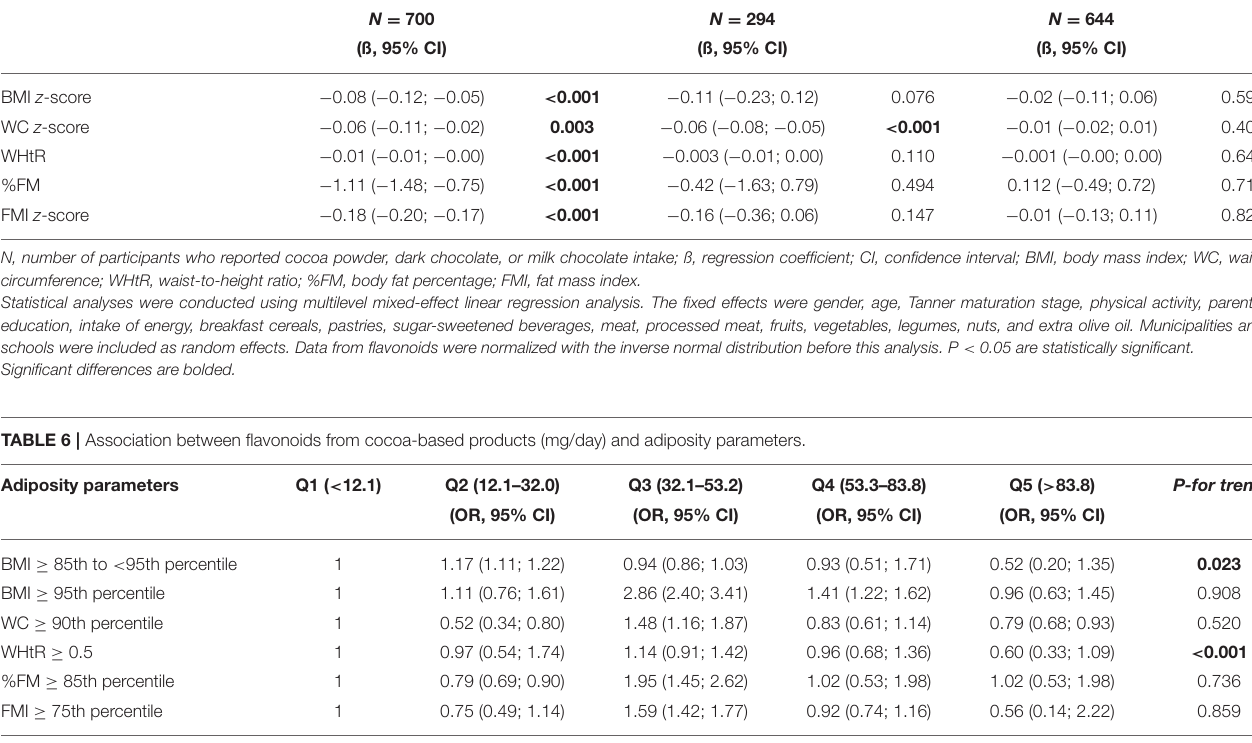
TABLE 5 | Association between flavonoids from cocoa powder, dark chocolate, and milk chocolate (mg/day) and anthropometric measurements. Anthropometric measurements Cocoa powder